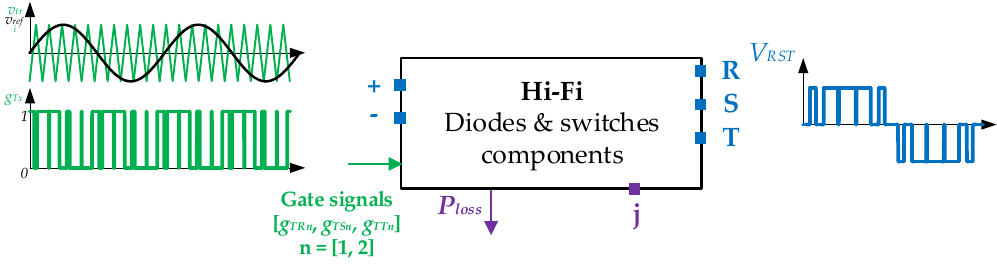
Figure 10. Hi-Fi model block. ( Left ) DC voltage nodes and the gate input Pulse Width Modulation (PWM) signal, g Tx . ( Right ) The AC R,S,T terminals and the AC voltage waveform. On the lower side, the thermal and power variables are shown.